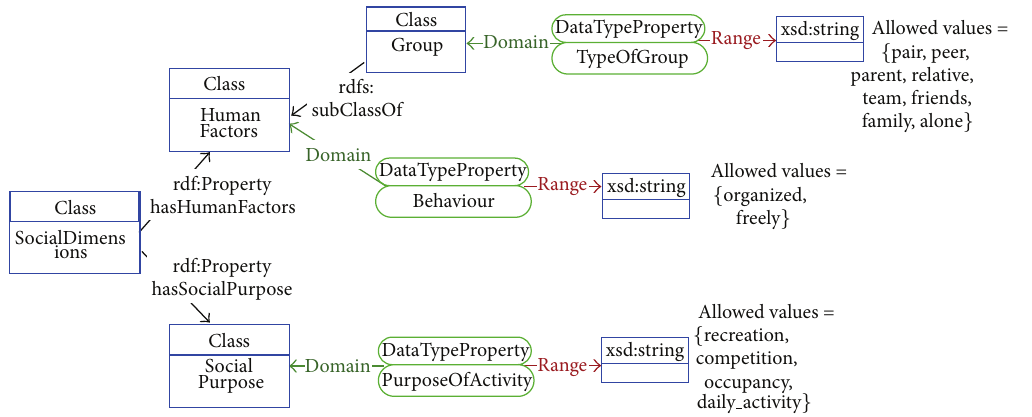
Figure 6: Conceptual diagram of information to characterize the social context associated with the physical activity.